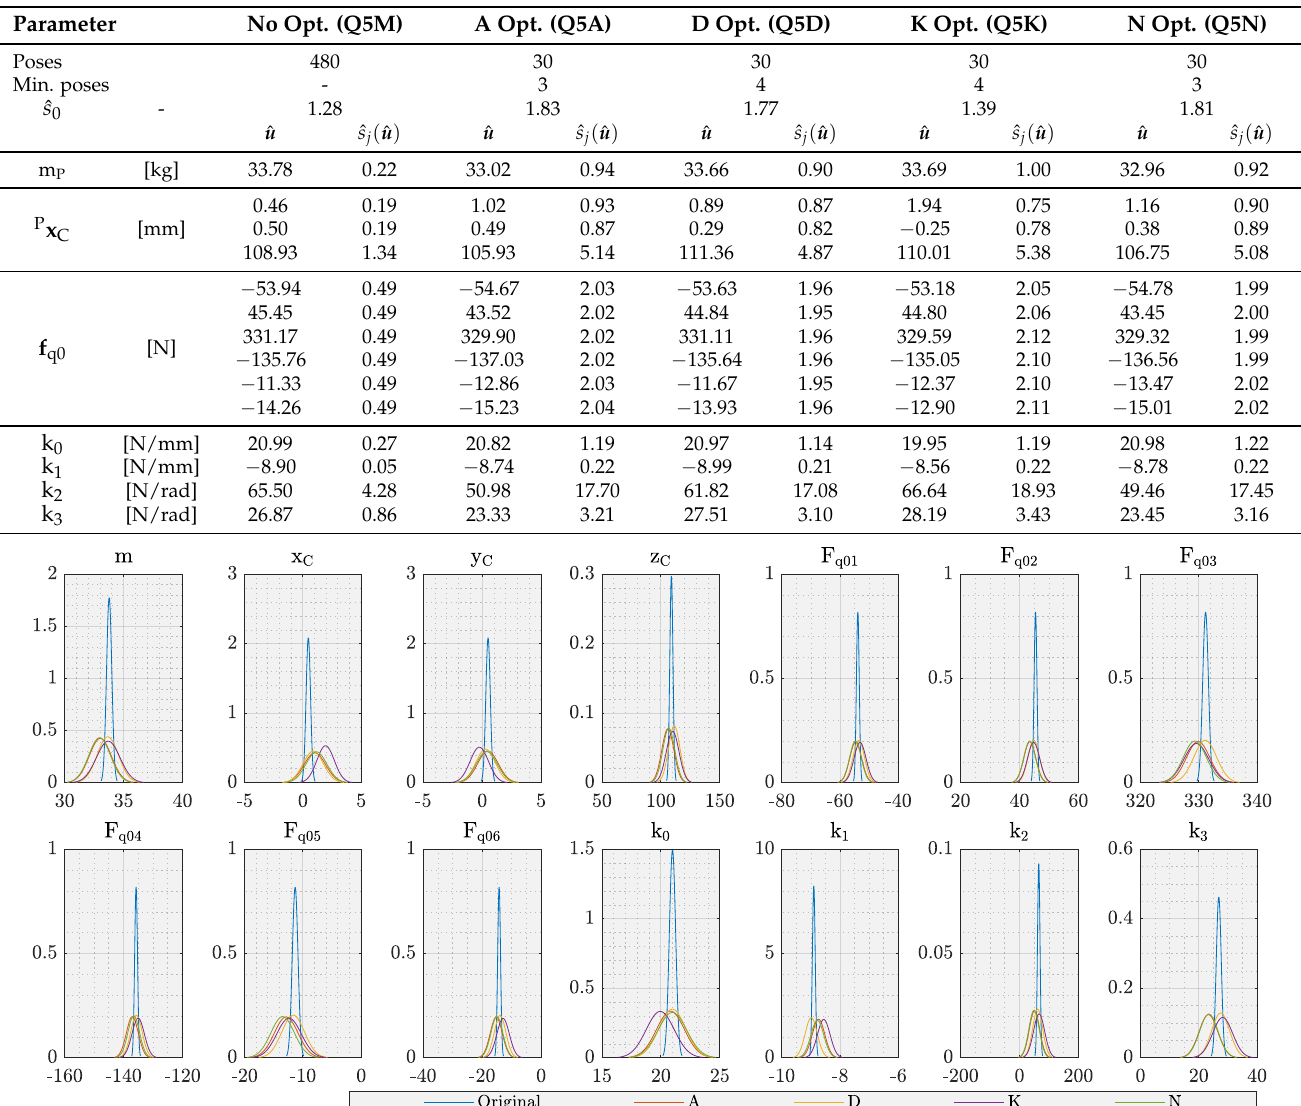
Table 5. Optimisation of quasi-static identification procedure with model 5 through a reduction of the number of poses to 30 starting from algorithmically generated 480 poses; last row: normal probability density plots for the parameters.